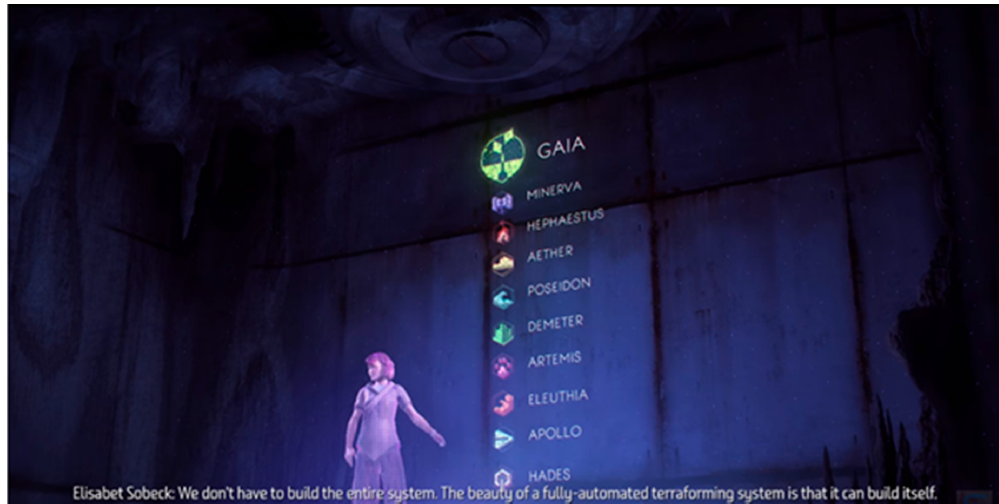
Figure 10. GAIA and her subsystems named after Greek gods and goddesses, and one Roman goddess. Table 1. An overview of the most important AIs and their primary mythological origins ( Horizon Zero Dawn Wikia n.d.; Smith 1872; Grimal 1996).